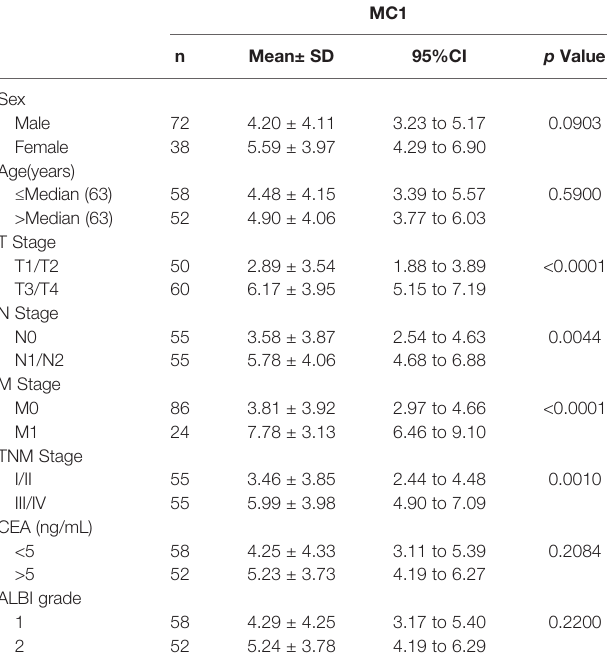
TABLE 4 | Clinical signi fi cance of MC1 in patients with